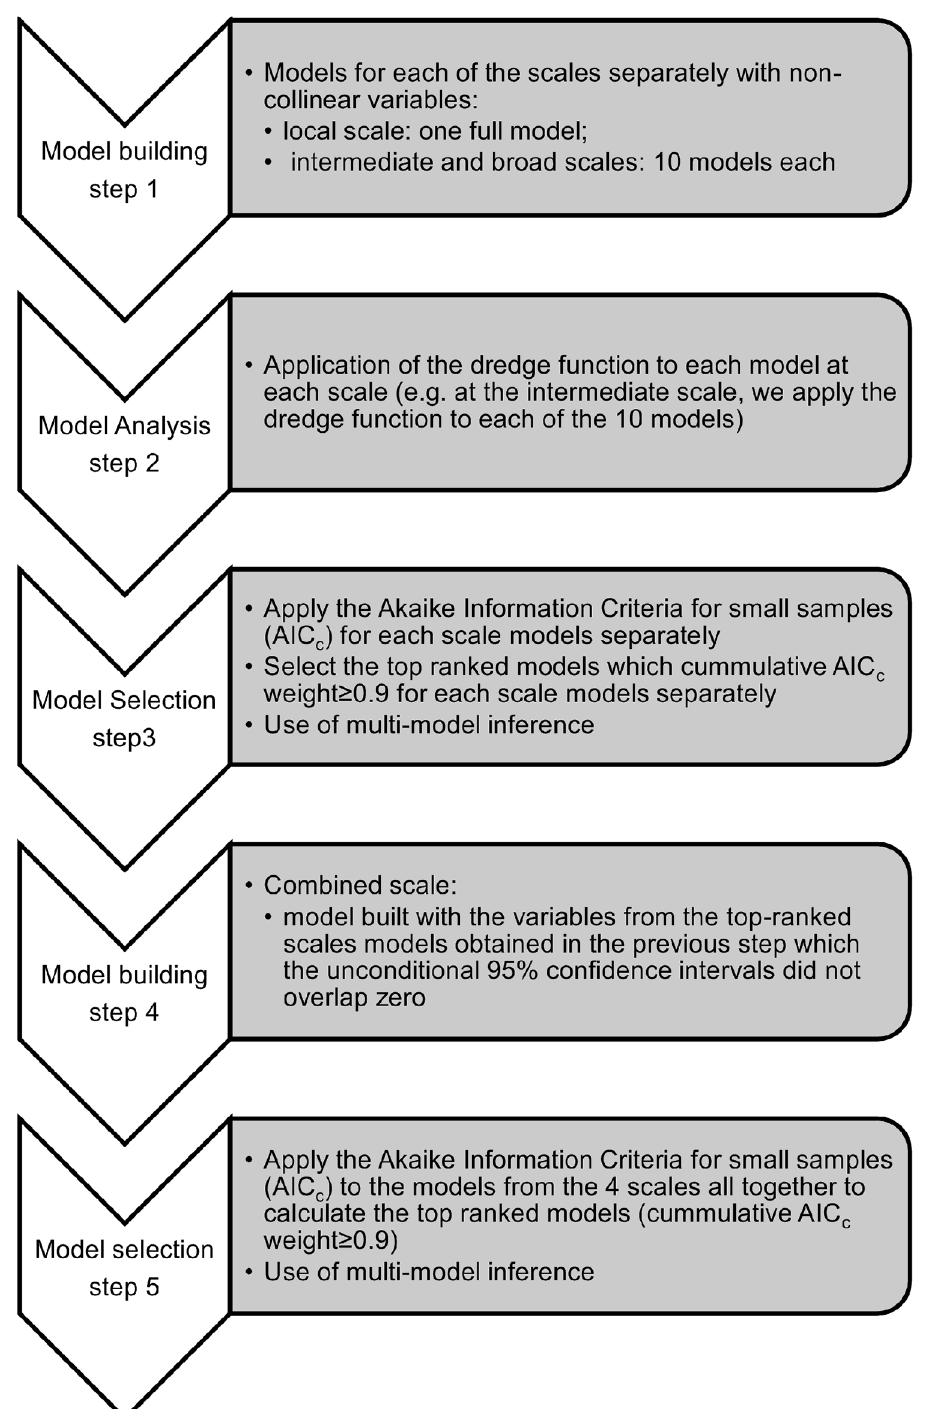
Fig 2. Flowchart describing the statistical analysis applied to the data.